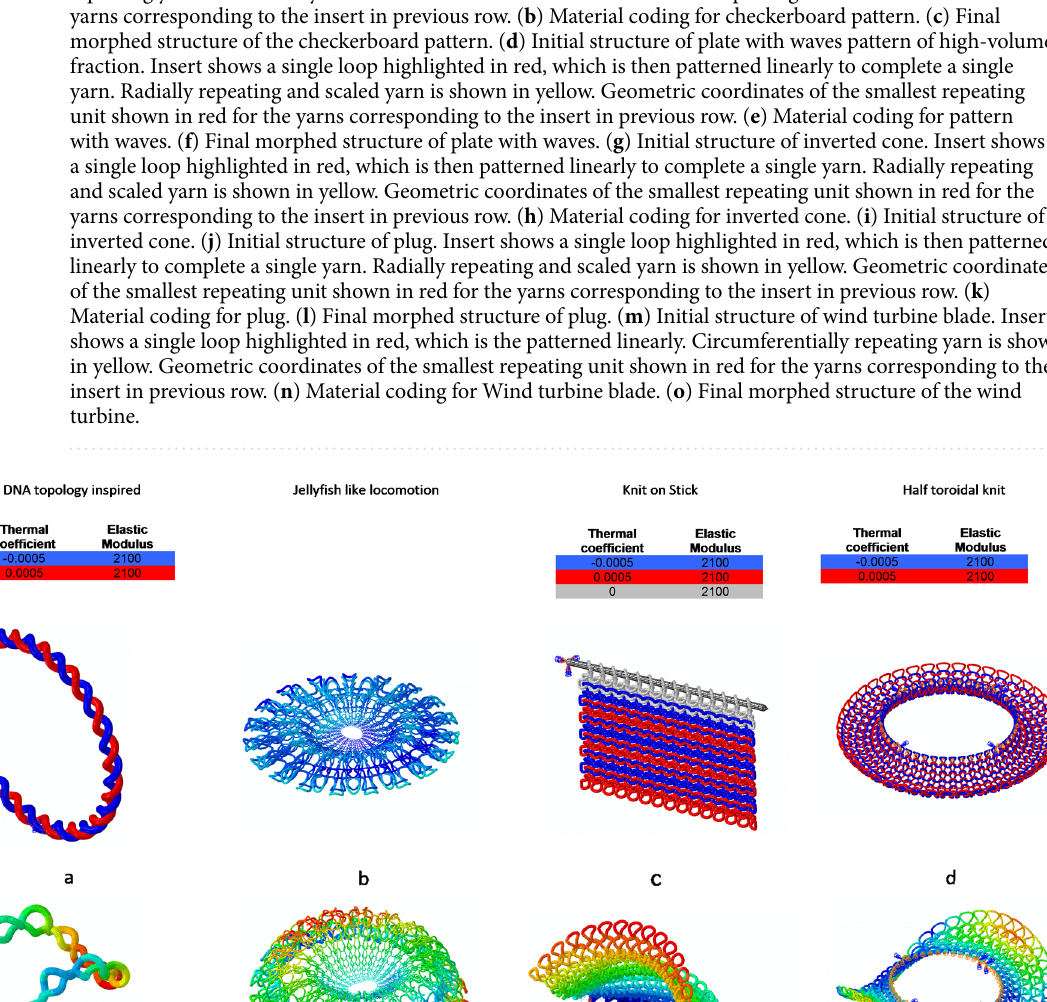
Figure 5. Conceptual work and inspiration. ( a ) DNA coiling inspired topology. Color coded material properties defined. ( b ) Jellyfish like aquatic motion can be achieved by alternating between the two configurations shown. Config 1. ( c ) A multi material knit on knitting needle. Color coded material properties defined. ( d ) Half toroidal composed of multi material yarns. Color coded material properties defined. ( e ) Morphed structures of the coiled DNA. ( f ) Jellyfish like aquatic motion can be achieved by alternating between the two configurations shown. Config 2. ( g ) Morphed structure of multi material knit. ( h ) Morphed structures of the Half